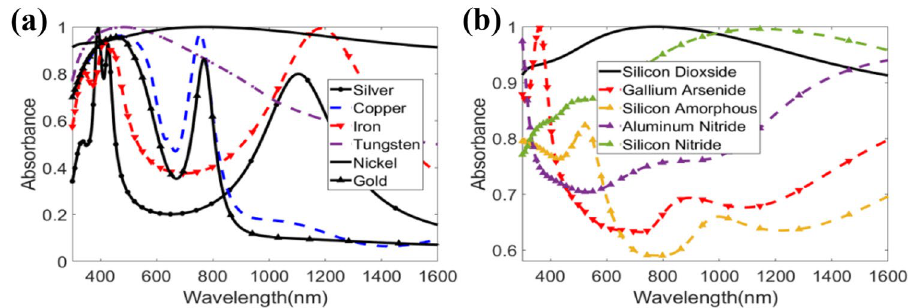
Figure 9. Absorption with different ( a ) metal layers, and ( b ) dielectric